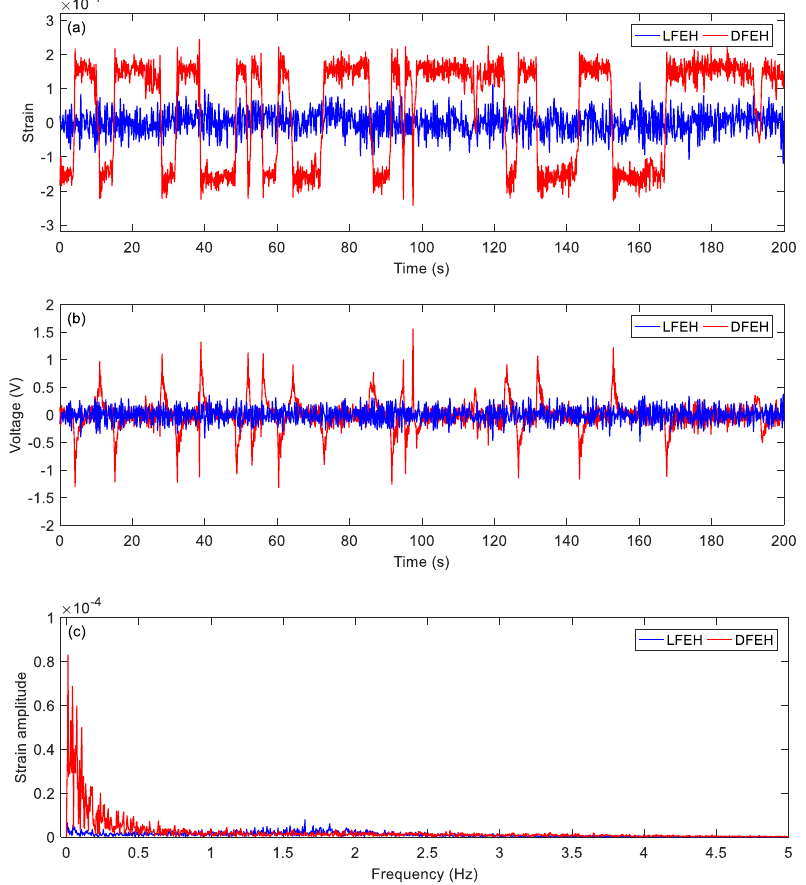
Figure 10. ( a ) Time histories of strain response, ( b ) time histories of voltage response ( c ) spectrum of strain ( v = 2.5 m/s).